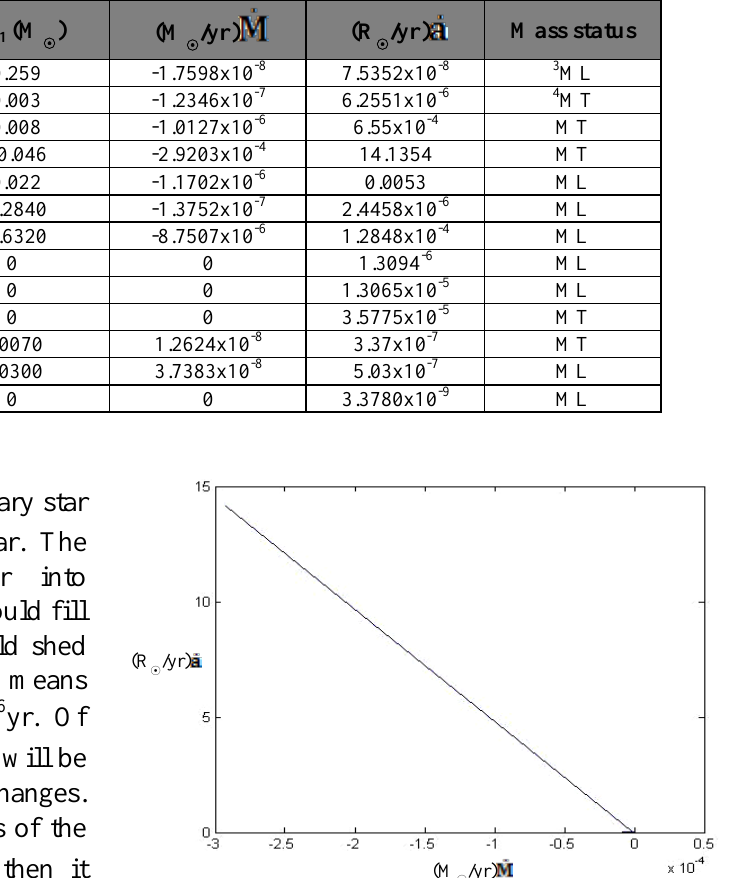
Fig.4: The relation between and in binary star system(13.6+8)M